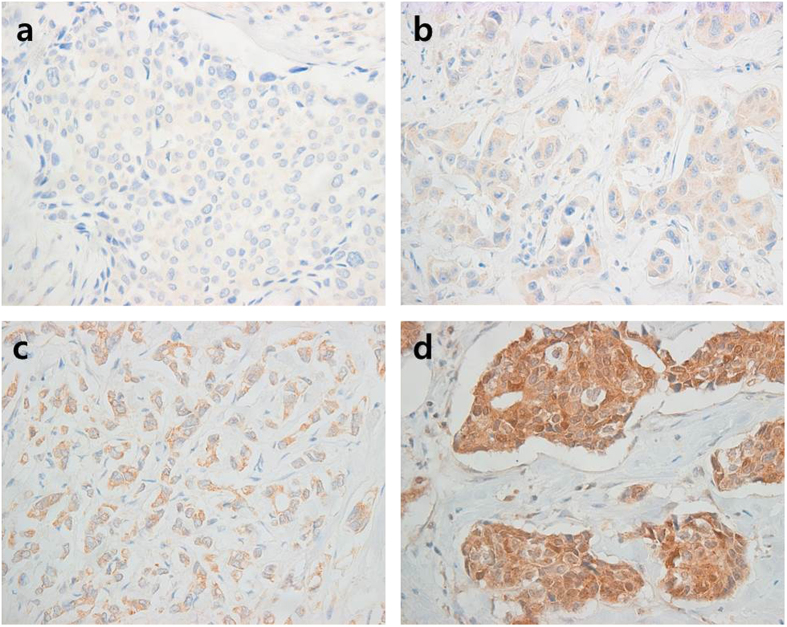
Immunohistochemical staining for RAE1.RAE1 expression levels are categorized as negative (a), weak (b), moderate (c), or strong (d) according to the RAE1 immunostaining signal intensity score (magnification, 400 ×).